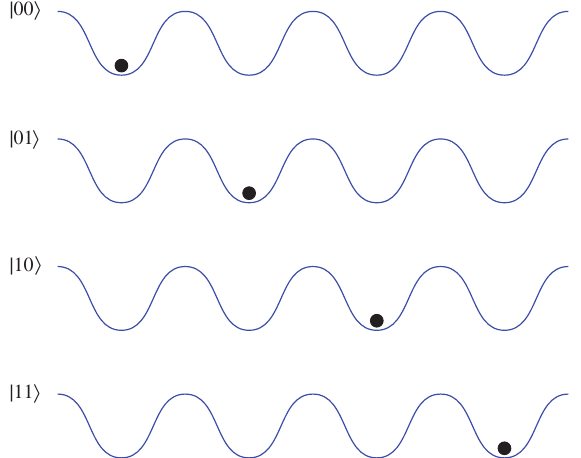
Figure 2: Unary encoding of a four-dimensional Hilbert space. Here, the wells represent optical modes and the black dot represents a single photon in that optical mode. The four states that span the Hilbert space correspond to a single photon in one of the four wells. This encoding is inefficient for a high dimensional space since it requires a lot of optical